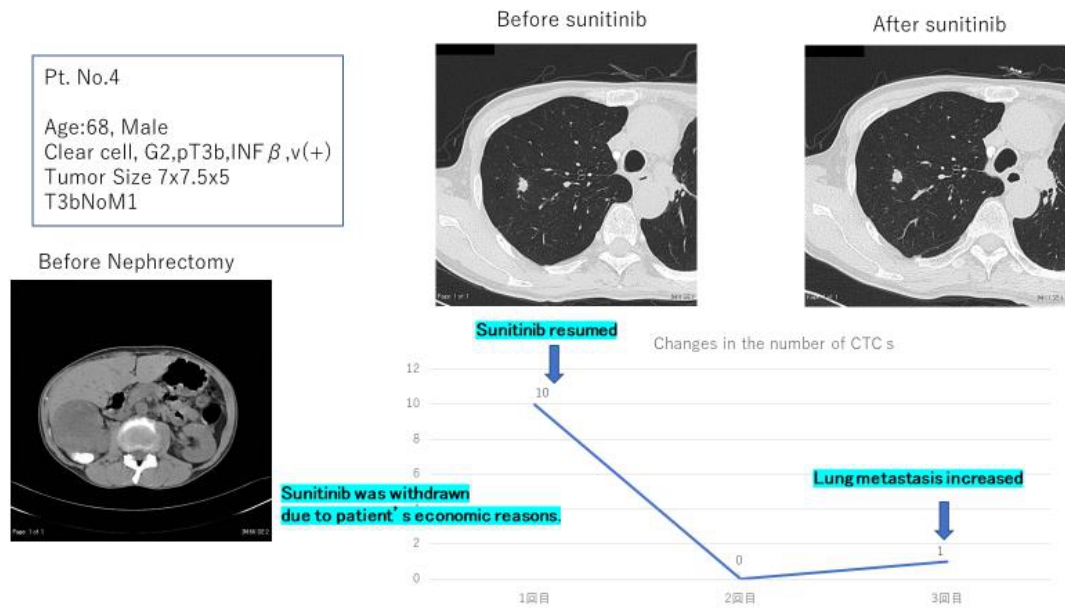
Figure 5. Changes in the number of CTCs during Figure 5. Ch anges in the number of CTCs during treatment.